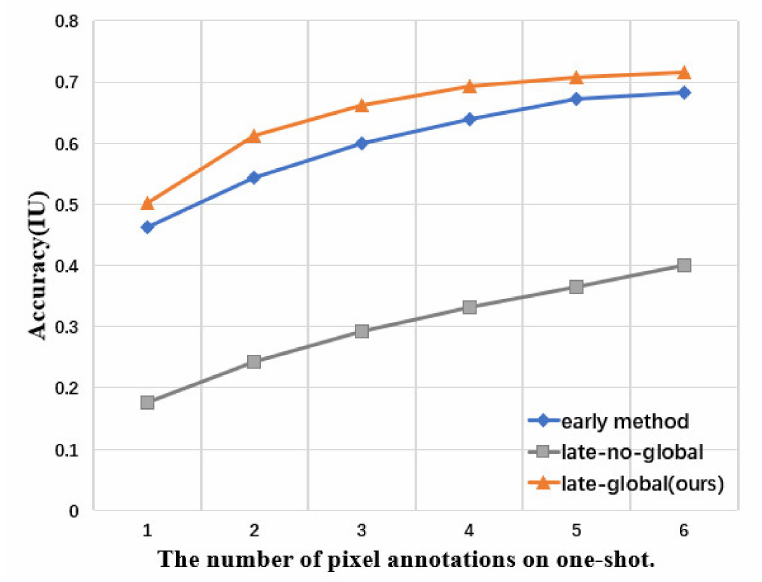
Figure 8. Interactive segmentation of objects in the support. The experimental results show that the accuracy of intersection-over-union (IU) is not significantly improved when the number of annotated pixels is more than